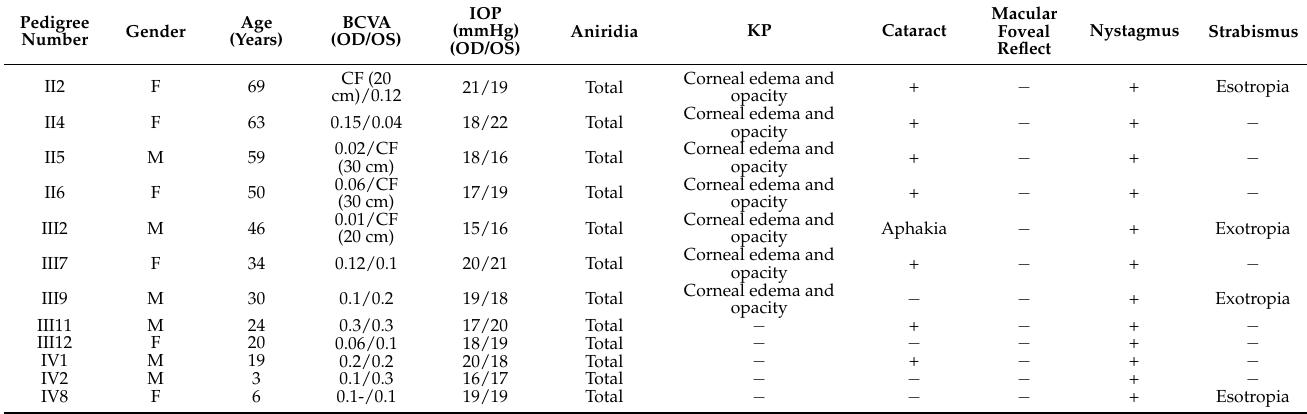
Table 1. Clinical details of patients of the recruited family.